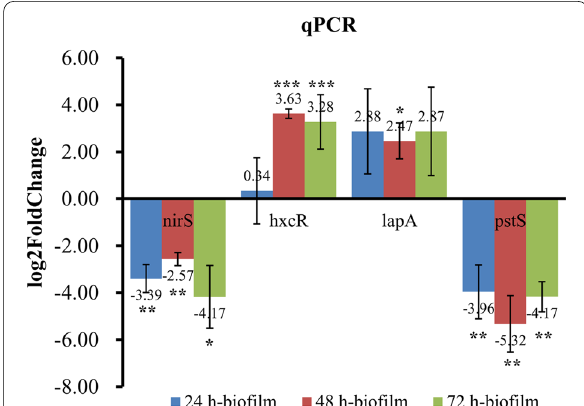
Fig. 4 Quantification of transcription of genes involved in the novel type II hxc secretion system and denitrification pathway in biofilm cells for different time. The data indicate the log 2 FoldChange expression of genes in biofilm cells compared to planktonic cells. The bars represent the mean and the standard error of the mean (mean SD). P values that are significantly different by T.test are indicated by asterisks as follows: *, P < 0.05; **, P < 0.01; ***, P < 0.001